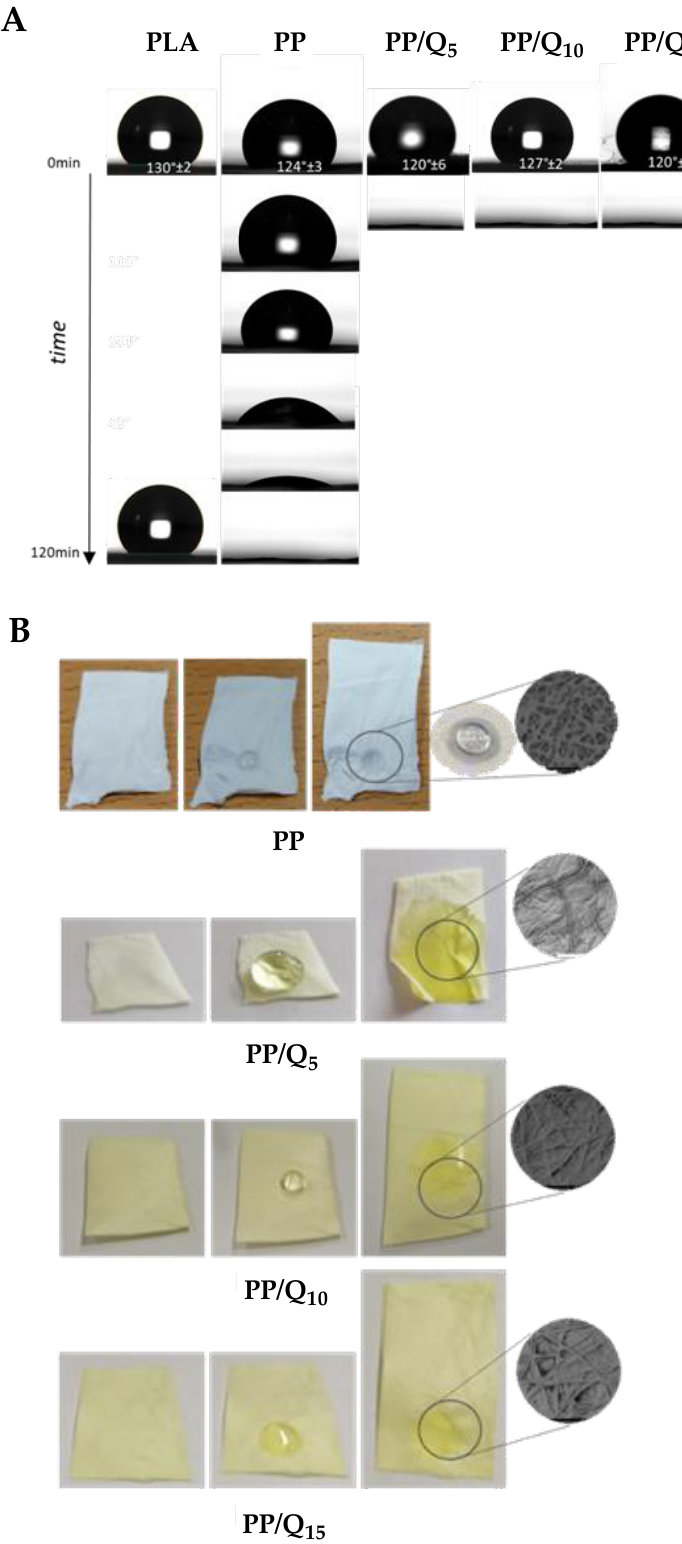
Figure 2. Behavior of synthetized membranes in contact with water: ( A ) water contact angle values of PLA, PP, PP/Q 5 , PP/Q 10 , and PP/Q 15 samples; ( B ) visual inspection and morphological analysis of PP, PP/Q 5 , PP/Q 10 , and PP/Q 15 surfaces.